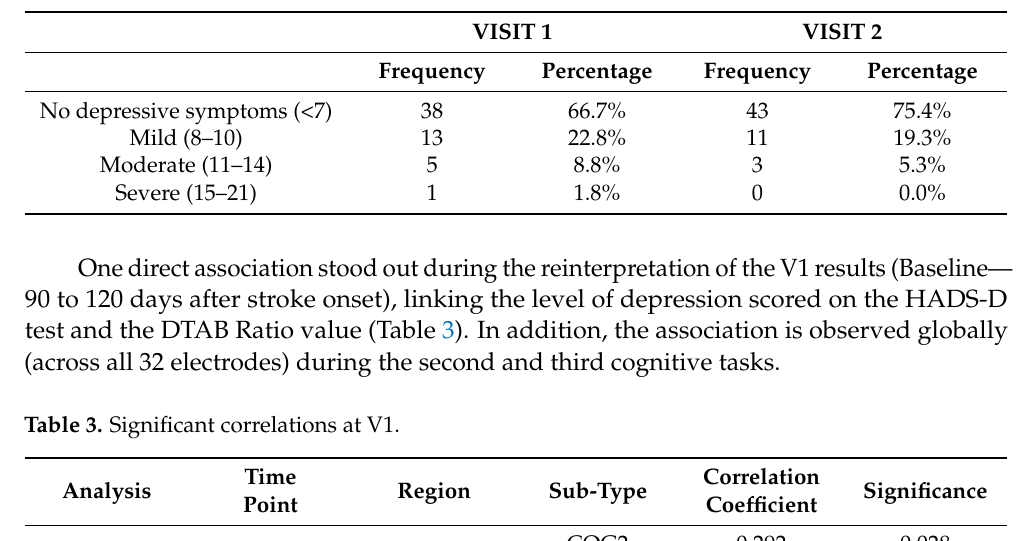
Table 2. HADS-D Scores—depressive symptoms.